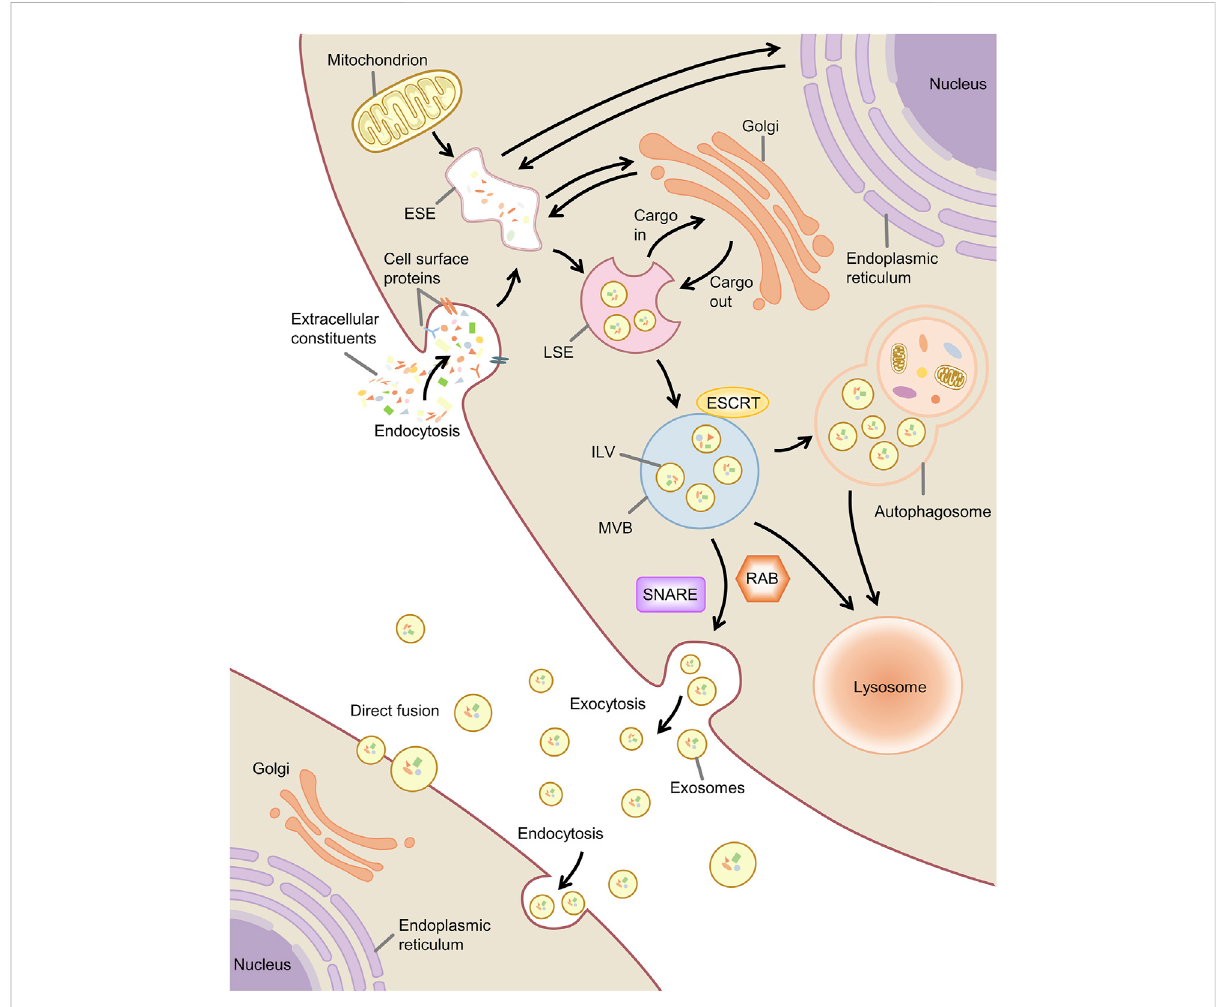
FIGURE 2 Biogenesis, secretion and uptake of exosome. Note: ESE, early-sorting endosome; LSE, late-sorting endosome; MVB, multivesicular body; ILV, intraluminal vesicle; ESCRT, endosomal sorting complex required for transport; SNARE, soluble N -ethylmaleimide-sensitive factor attachment protein